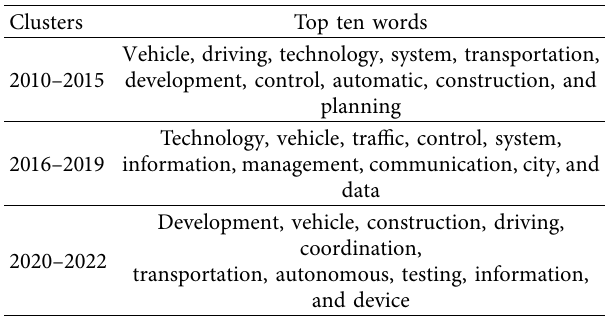
Figure 7: Te clustering result shows that among 3-class, K-means can divide an accurate timeline. Table 2: Sorted by the weight of words, the top ten words of each Table 3: Sorted by the weight of words, the top three components cluster are shown. of each generation are